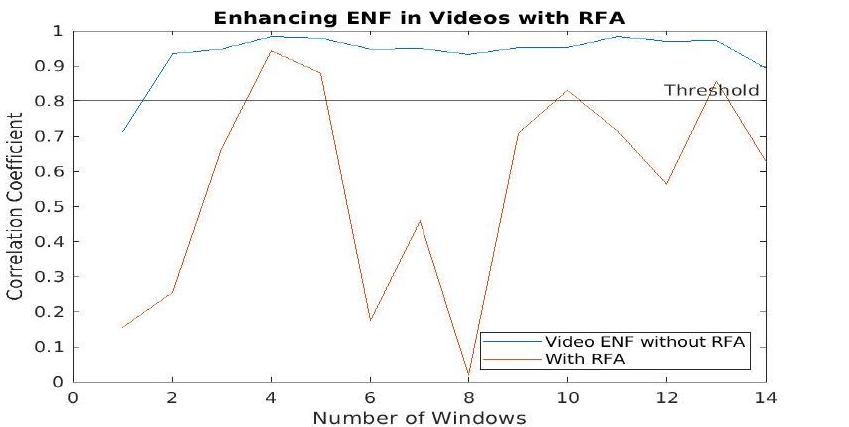
Figure 6. Enhancing the embedded ENF signature with the RFA in video recording with a low SNR and external noise.